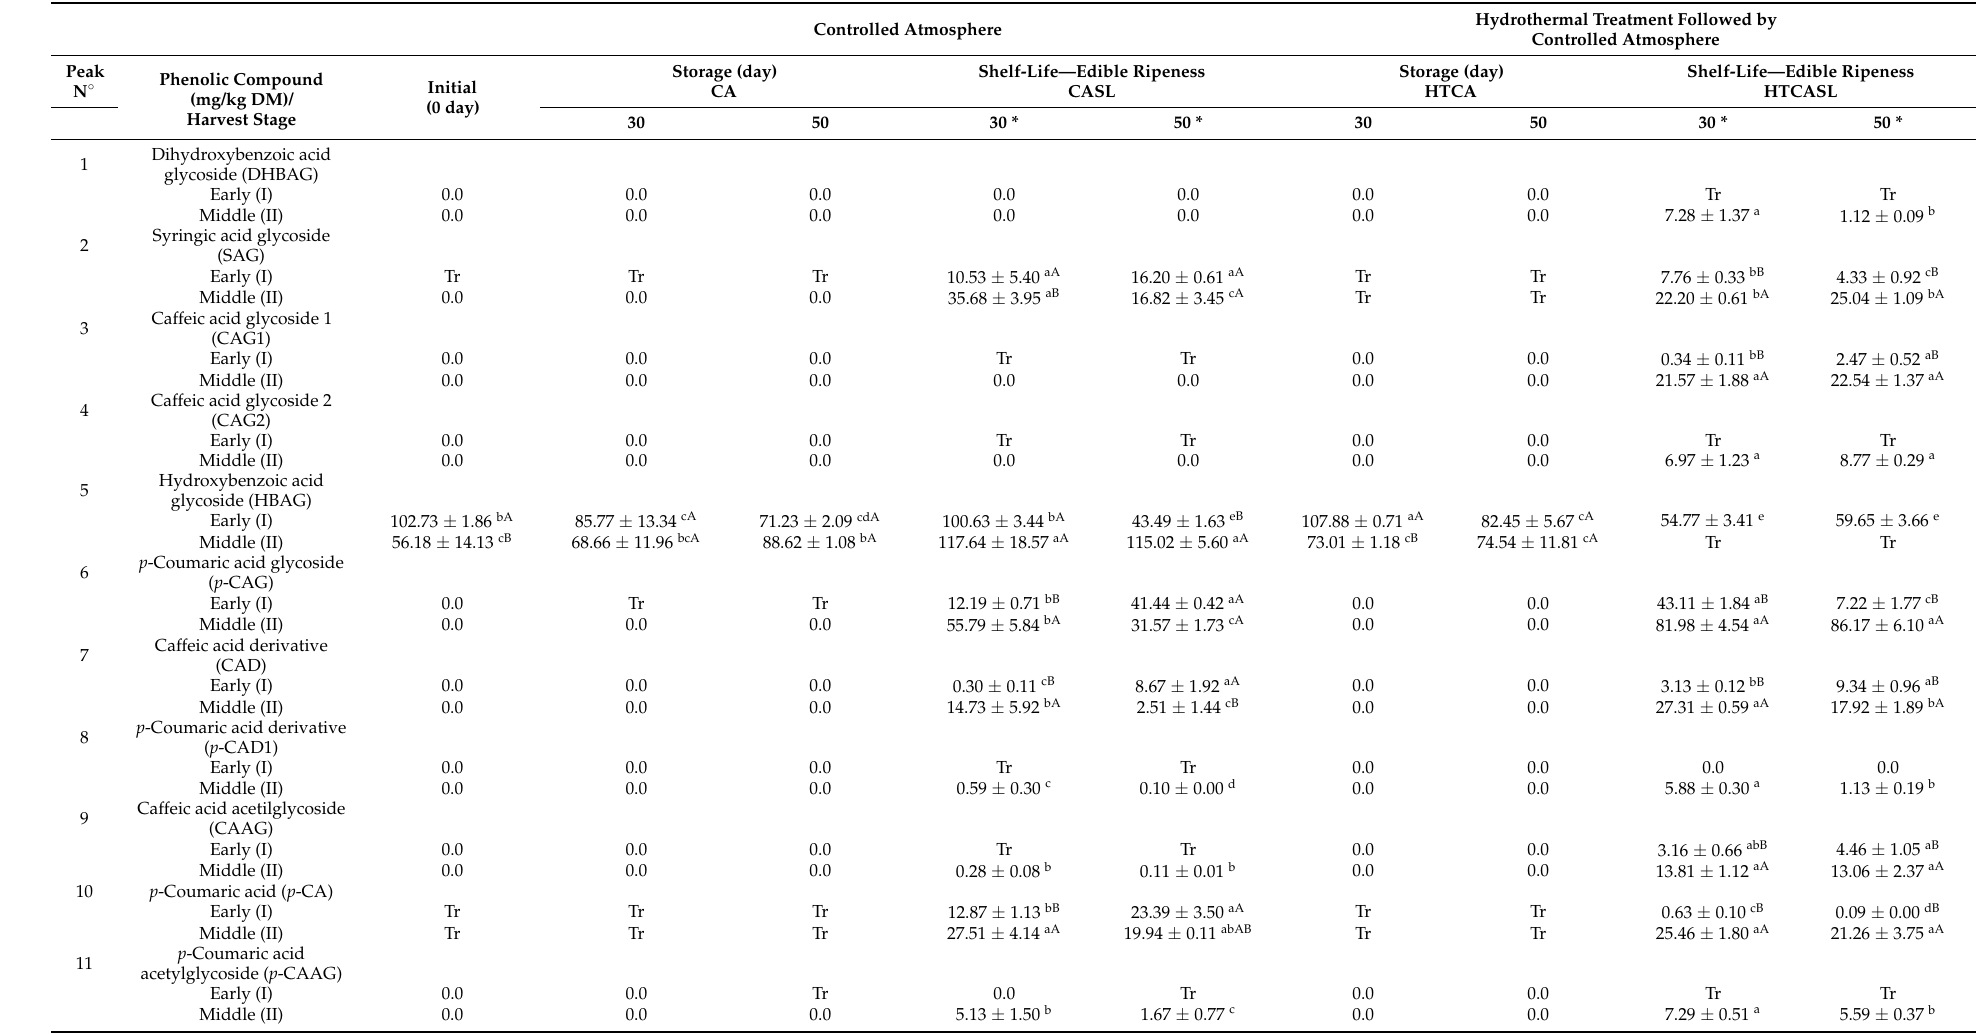
Table 3. Main phenolic compounds content determined by LC-MS e and PDA in Hass avocado from two harvests (early and middle) at harvest (initial), after controlled atmosphere storage, and with previous hydrothermal pretreatment followed by controlled atmosphere storage, and at their corresponding edible ripeness. Controlled Atmosphere Hydrothermal Treatment Followed by Controlled